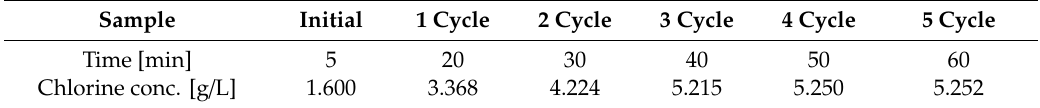
Table 2. Chlorine concentration of electro-generated